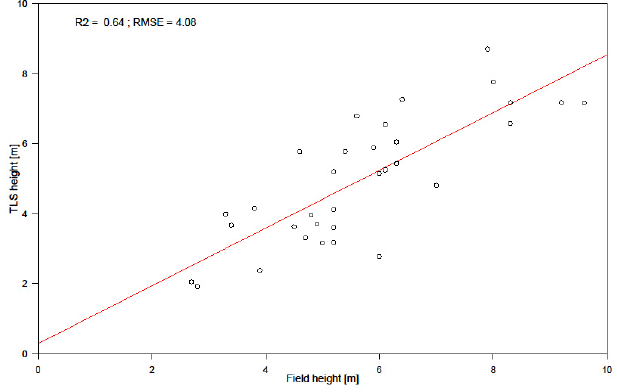
Figure 6. Validation results of field measured height and TLS canopy height.